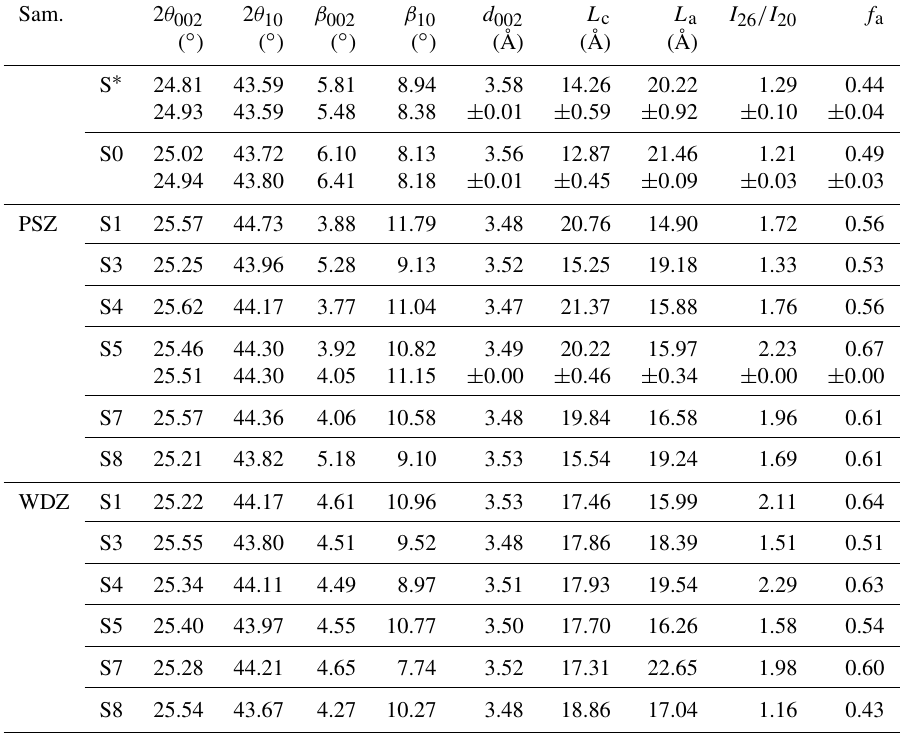
Table 3. Coal crystal structure parameters determined from XRD profiles.